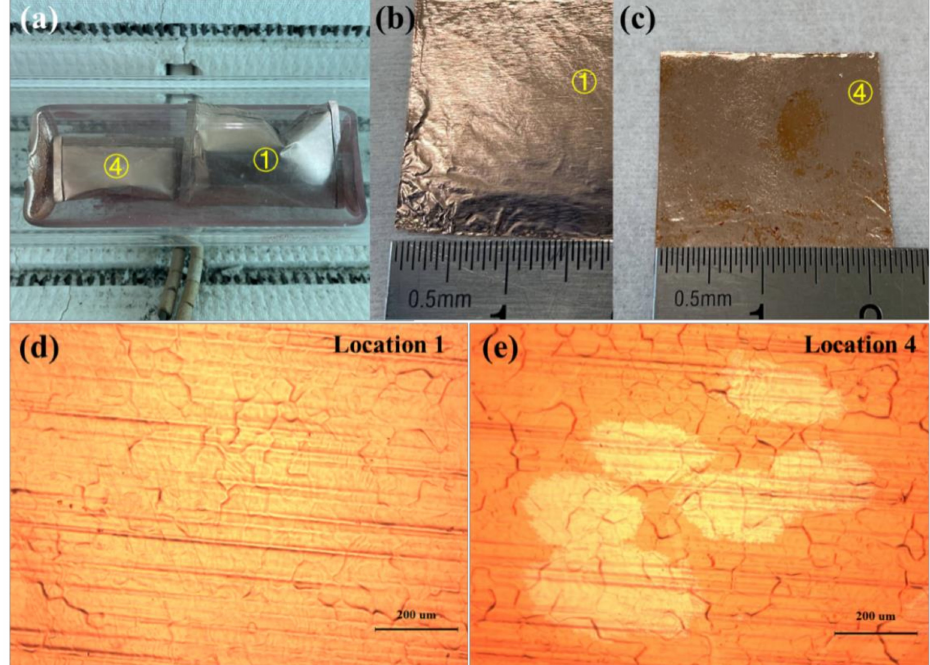
Figure 3. ( a ) Optical picture of the two copper pockets placed in the quartz boat in the second group of experiments. ( b , c ) Optical picture of the inner surfaces of the copper pockets at location 1 and location 4 after oxidation treatment. ( d , e ) Optical micrograph of the inner surfaces of the copper pockets at location 1 and location 4 under 100-times